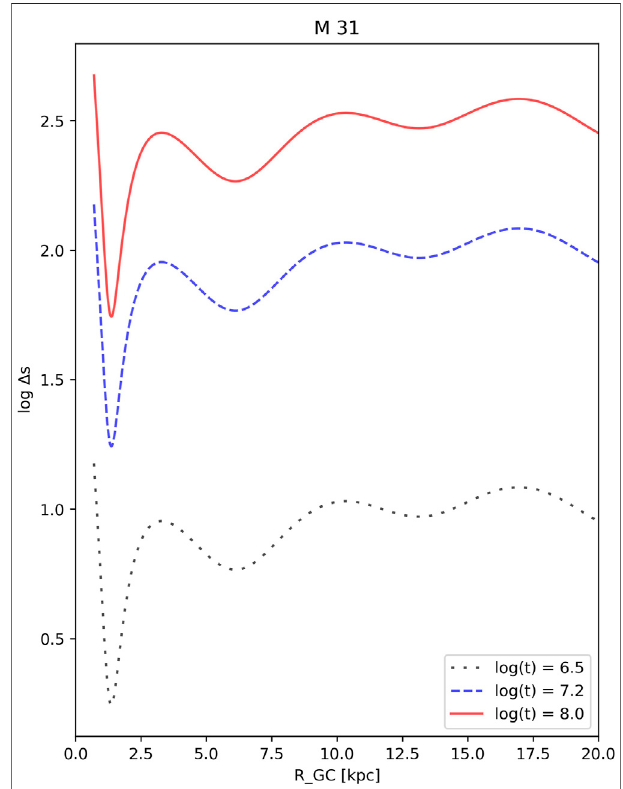
FIGURE 2 | The orbital drift of the open cluster in M 31 from their host spiralarmasafunctionofthegalacto-centricradiusandtime.Thevaluesof Δ s under the logarithm are in parsec. Used parameters: Ω p (cid:1) 15 km/s/kpc, Δ R (cid:1) 0 . 1 kpc,rotationcurvefromSofueetal.(1999),approximatedbya high-degree polynomial (deg >